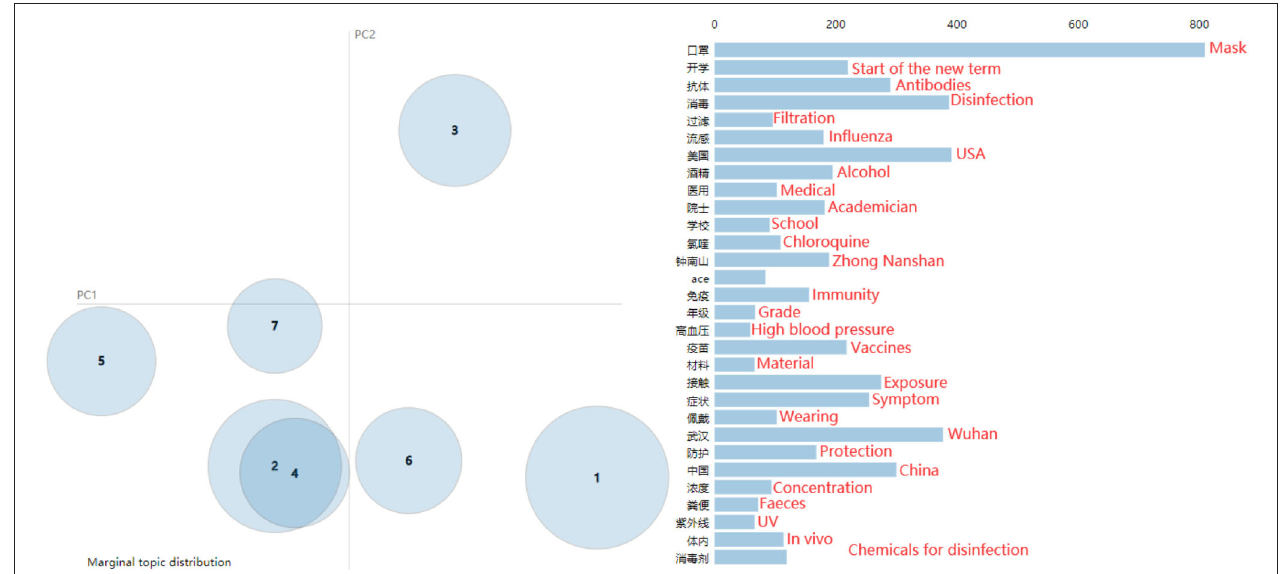
FIGURE 6 | Visualization of